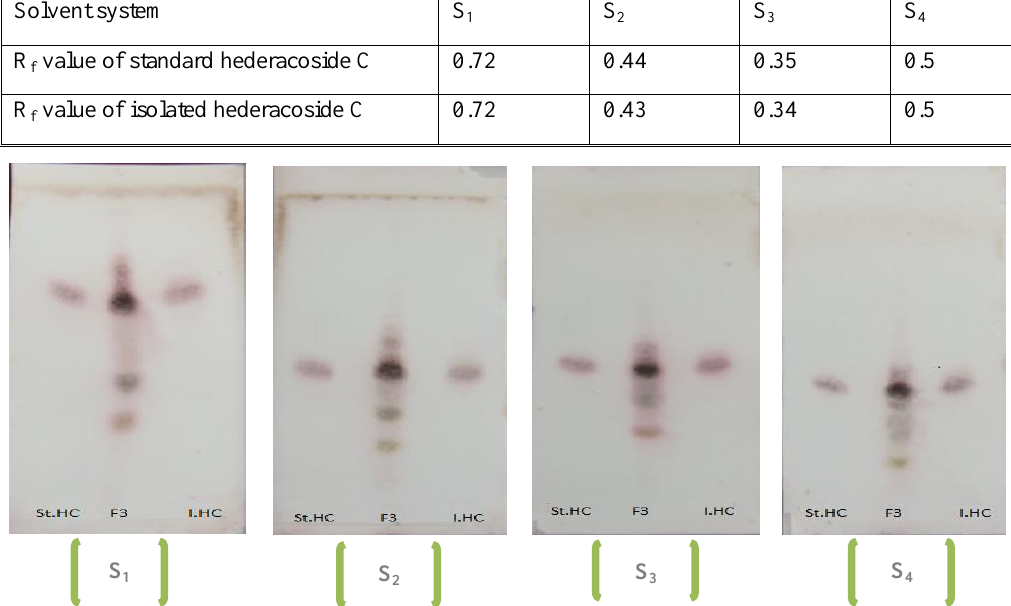
Figure 2: TLC of hederacoside C standard( St.HC ), the major fraction (F3), and isolated hederacoside C ( I.HC ), using four solvent systems (S Detection by Liebermann-Burchard reagent.